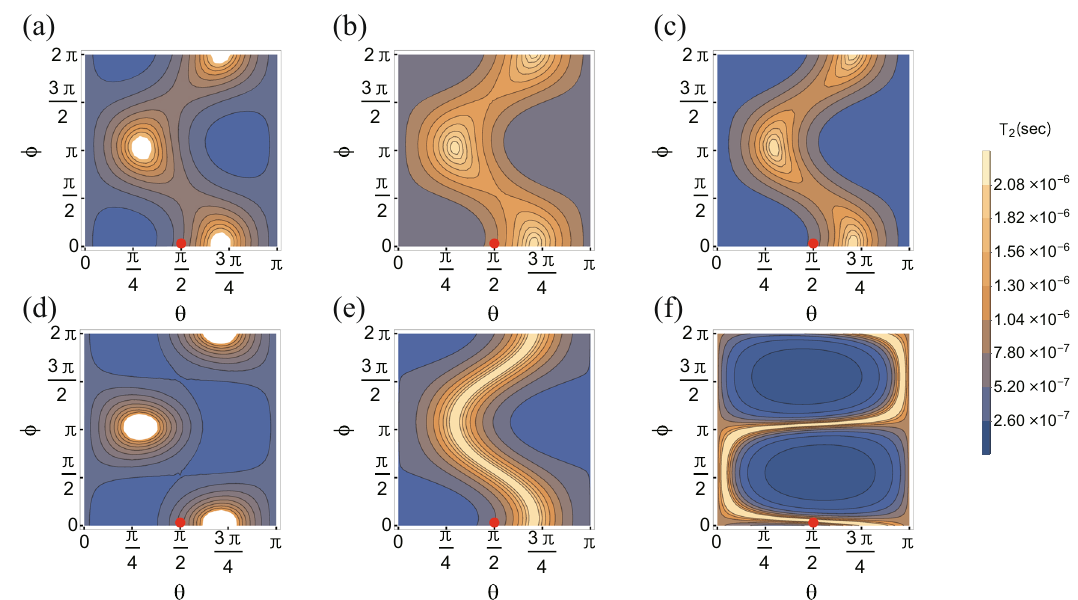
Fig. 2 The anisotropy maps of decoherence time T 2 . x and y axes are the polar angle θ and the azimuthal angle ϕ with respect to the device's z -direction, respectively. The models used for simulations are: a uniformly distributed random dipoles (UD), b uniformly distributed traps (UT), c and d single dipole cluster (CD) located at ( x , y , z ) = (37, 0, 37) nm and ( x , y , z ) = (0, 37, 37) nm respectively, e and f single trap cluster (CT) located at ( x , y , z ) = (37, 0, 137) nm and ( x , y , z ) = (0, 37, 137) nm respectively. The qubit is located at the origin. The applied fi eld direction ( θ , ϕ ) = ( π /2, 0) used in the experiment is indicated by the red dot. For the uniform distribution models in a and b , the volume density ρ density ρ a are respectively used as fi tting parameters to match T 2 ( π /2, 0) to the experimental value, 840 ns, and for single cluster models in c – f the dipole strength p 0 is used as a fi tting ¼ 2 : 01 μ s sets an upper bound on the plotted values in Fig. 2. The white regions in Fig. 2a and d represent angular regions where the charge noise contribution is negligible and this upper bound is reached. Figure 2a shows the results for the UD model and Fig. 2b for the UT model. The horizontal (vertical) axis denotes polar (azimuthal) angle with respect to the device ’ s z -direction. The key feature of these two models is that anisotropy of T 2 results only from the magnetic fi eld gradients. The patterns are not too dissimilar, with the ratio between maximum and minimum values being around 3 for the UD model and 2 for the UT model. The main difference between